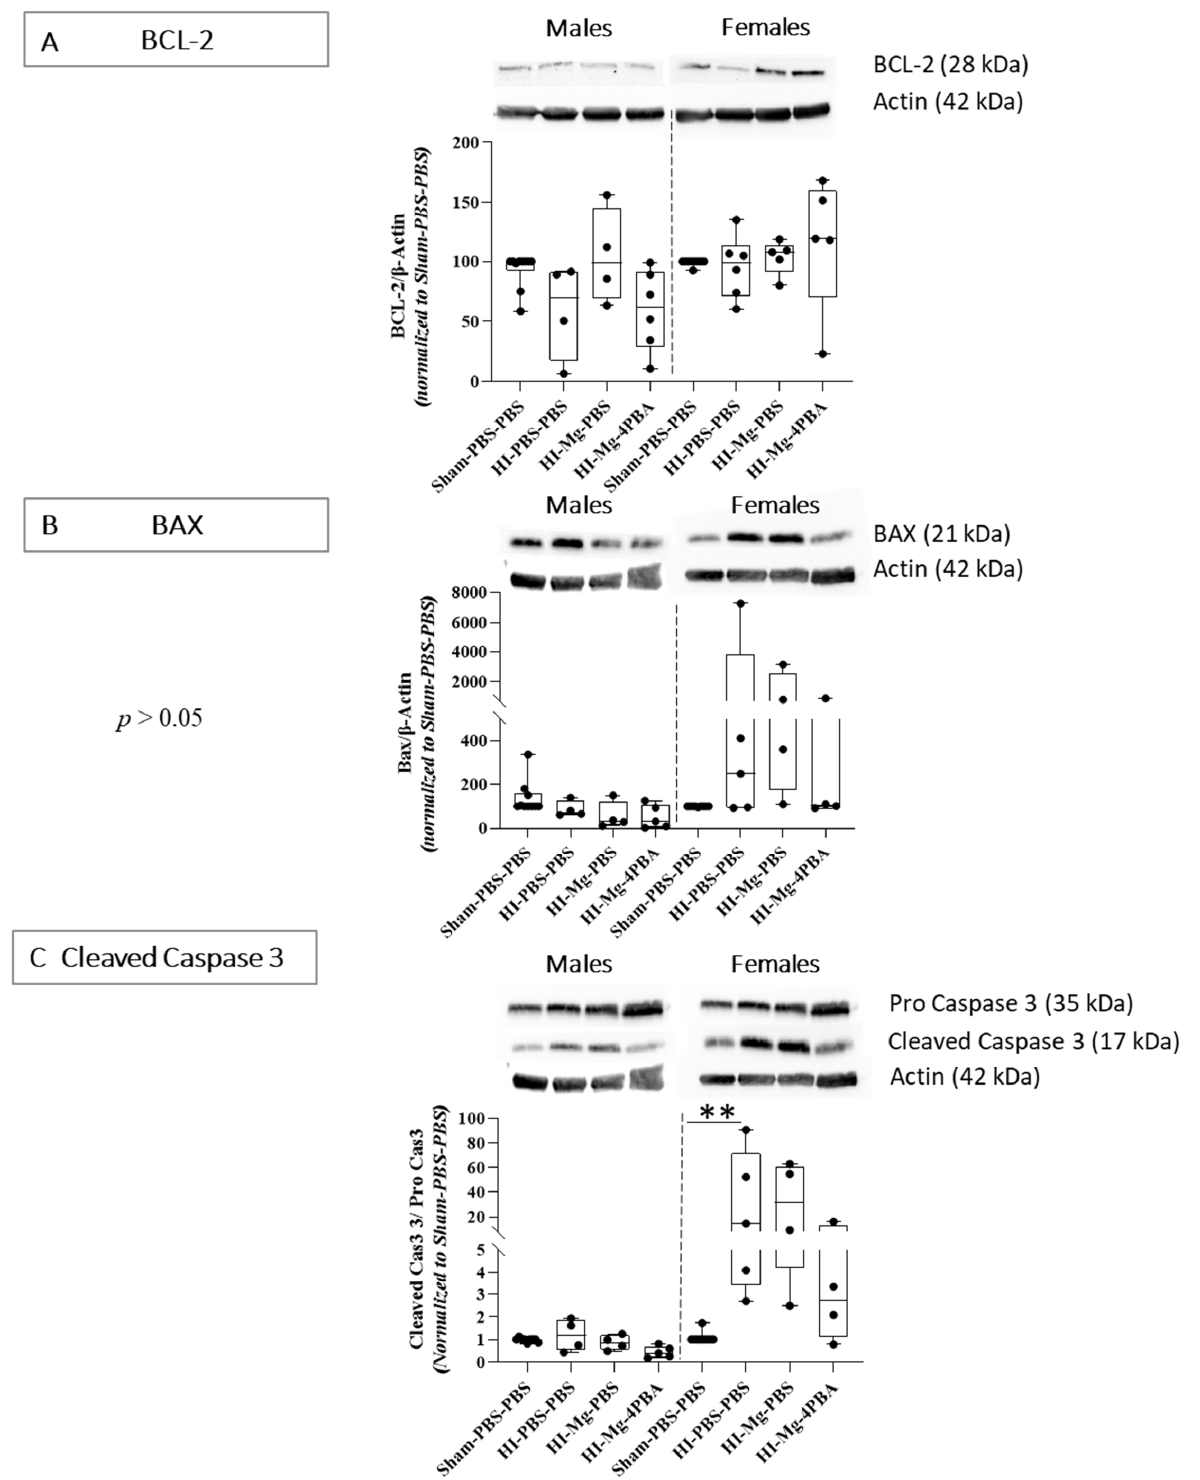
Figure 4. Effects of the neonatal HI, MgSO 4 or of the MgSO 4 /4-PBA association on mitochondrial apoptotic proteins expression at P6. ( A )—BCL-2 protein level 24 h after surgery. ( B )—BAX protein level 24 h after surgery. ( C )—Ratio of cleaved caspase 3 protein level over pro-caspase 3 protein level 24 h surgery. Data were normalized to the Sham-PBS–PBS group and expressed as median with min and max values, n = 4–10 males/group; 4–9 females/group. The Kruskal–Wallis test was performed followed by Dunn’s post hoc test (** p <